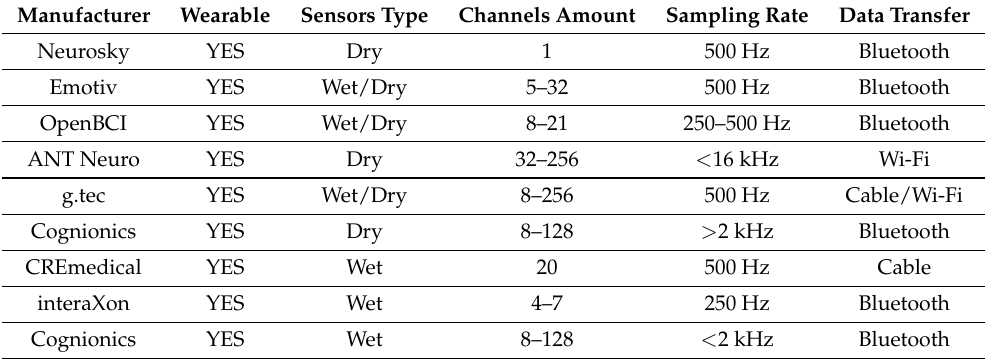
Table 3. Some of the most popular inexpensive, off-the-shelf BCI systems—summary